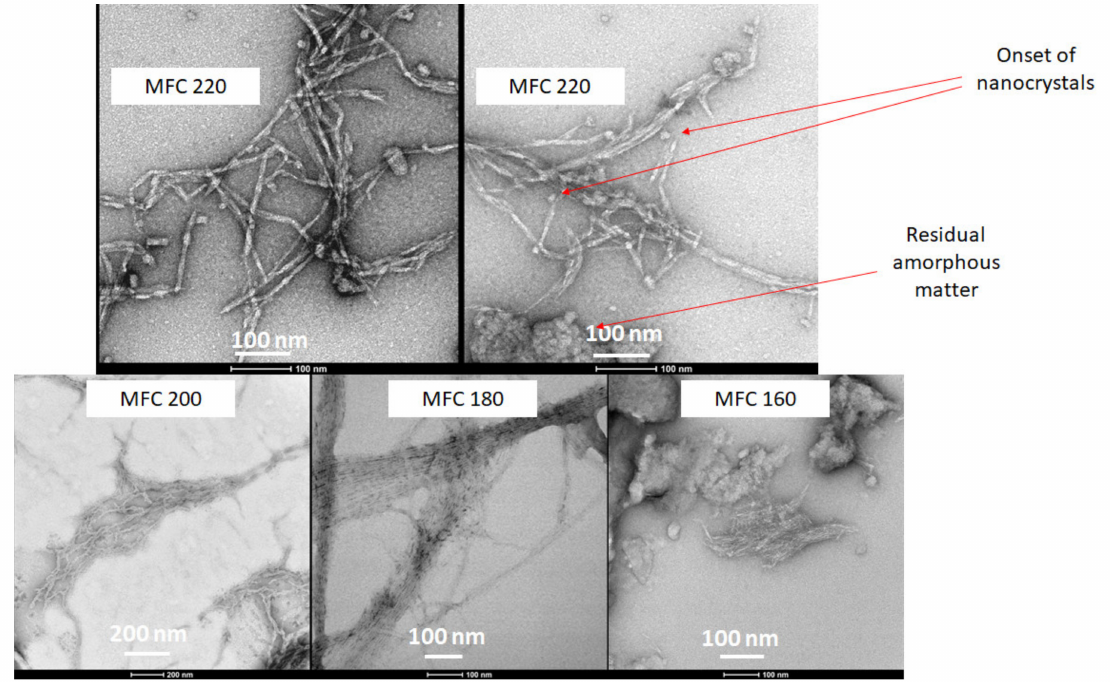
Figure 9. TEM images of MFC samples at different temperatures as labelled. MFCXXX corresponds to microfibrillated cellulose processed at XXX ◦